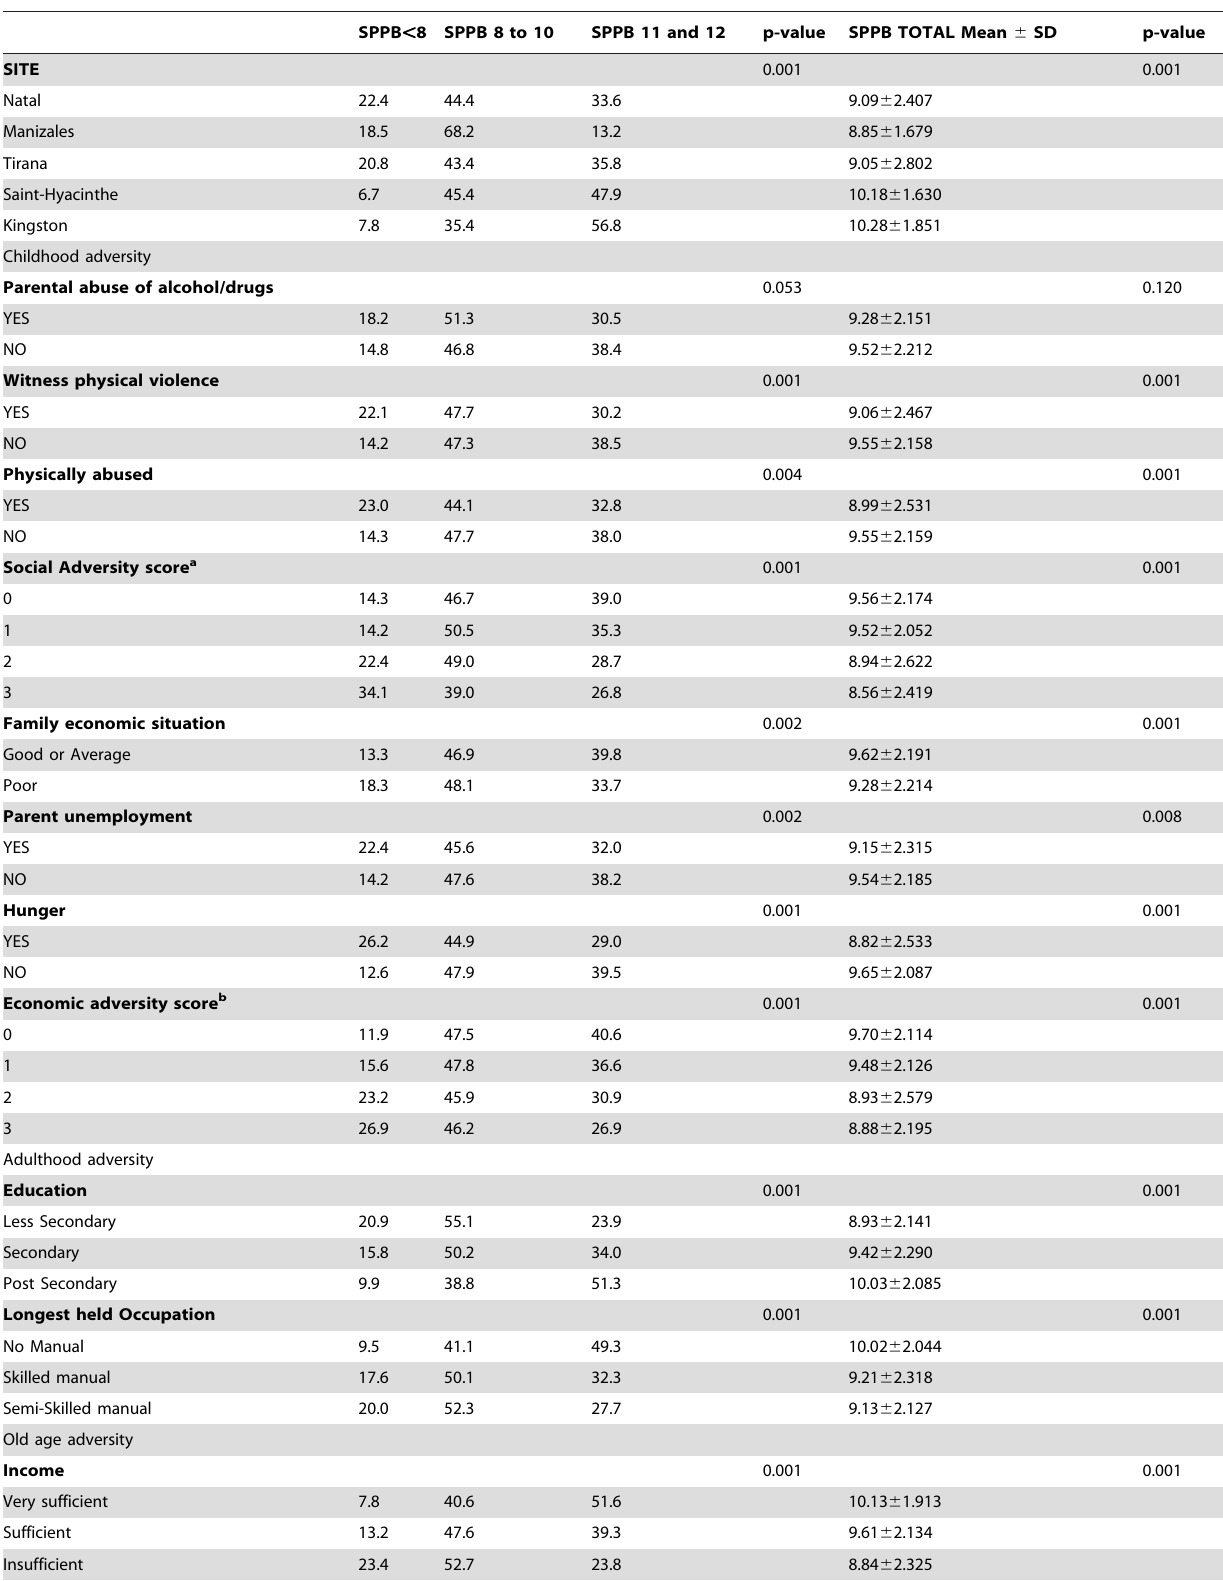
Table 2. Short Physical Performance Battery by Site and Lifecourse Adversity